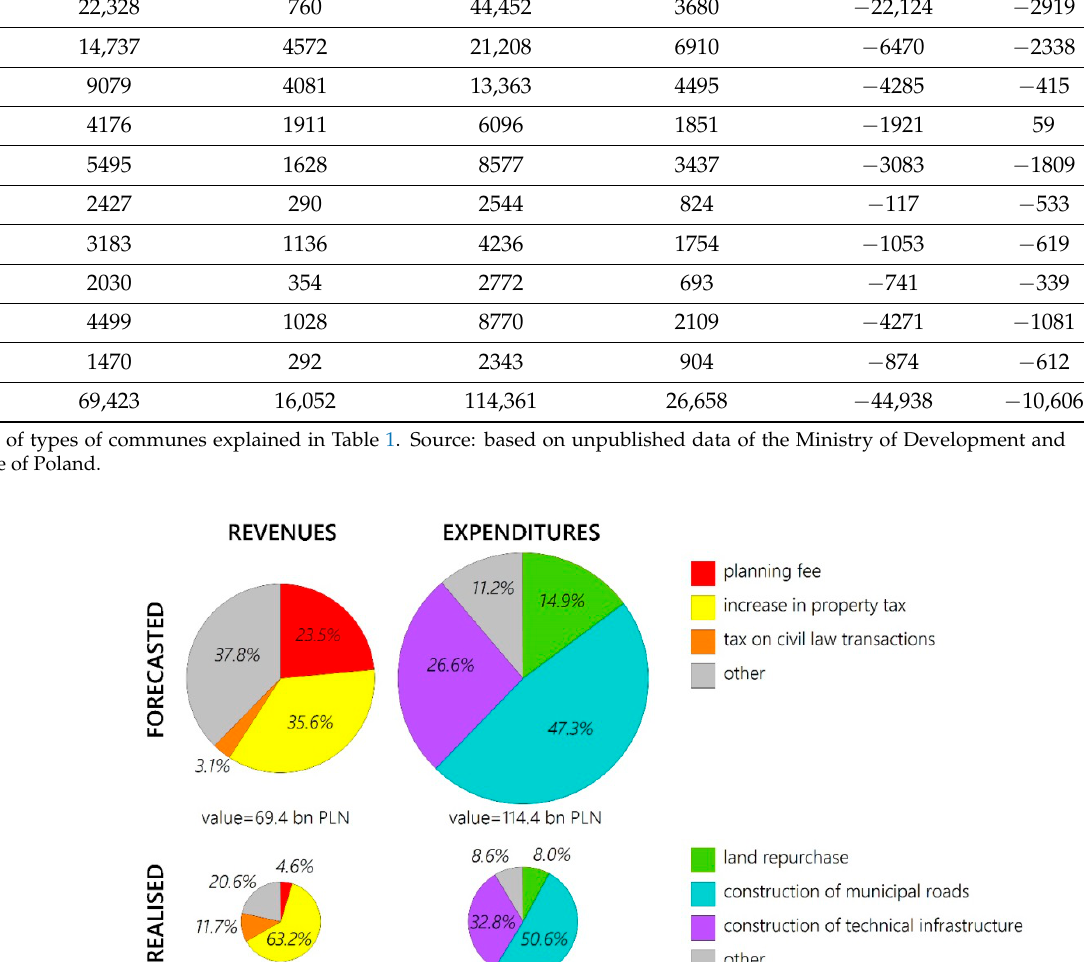
Table 2. Basic quantitative information on the forecasted and realized incomes and expenditures related to adopting local spatial development plans in 10 types of communes, for the year 2019.